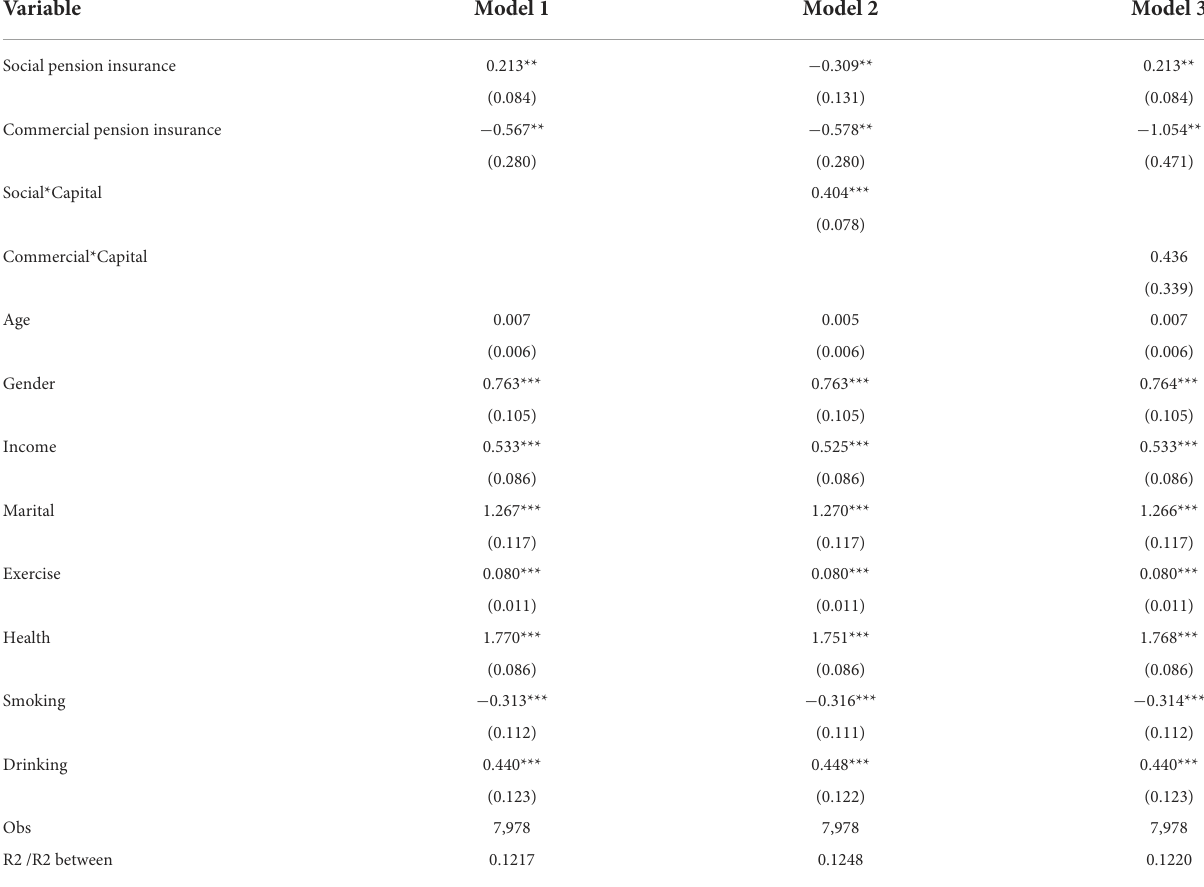
TABLE 5 Regression results for narrowing time